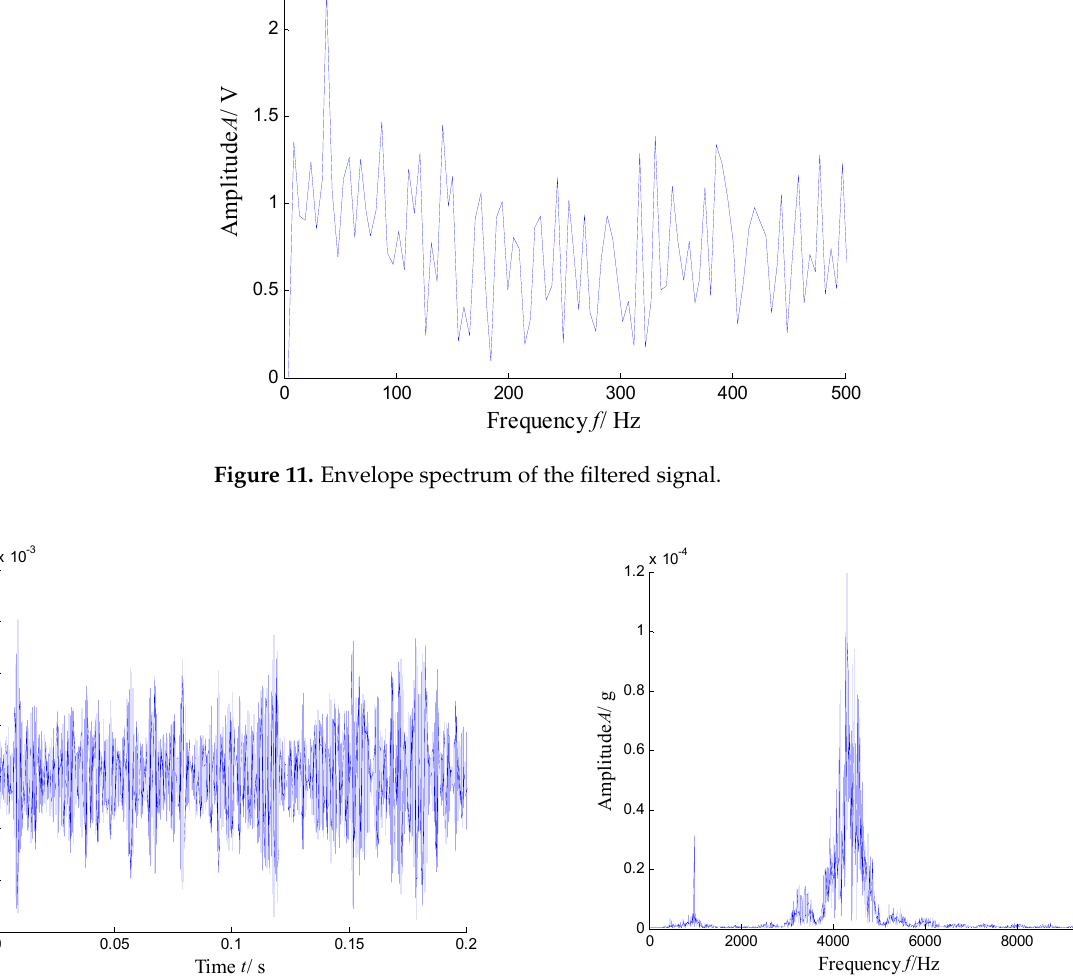
Figure 12. Waveform and spectrum of the 4th subspace obtained by the RSVD method: ( a ) waveform of the reconstructed signal and ( b ) spectrum of the reconstructed signal.